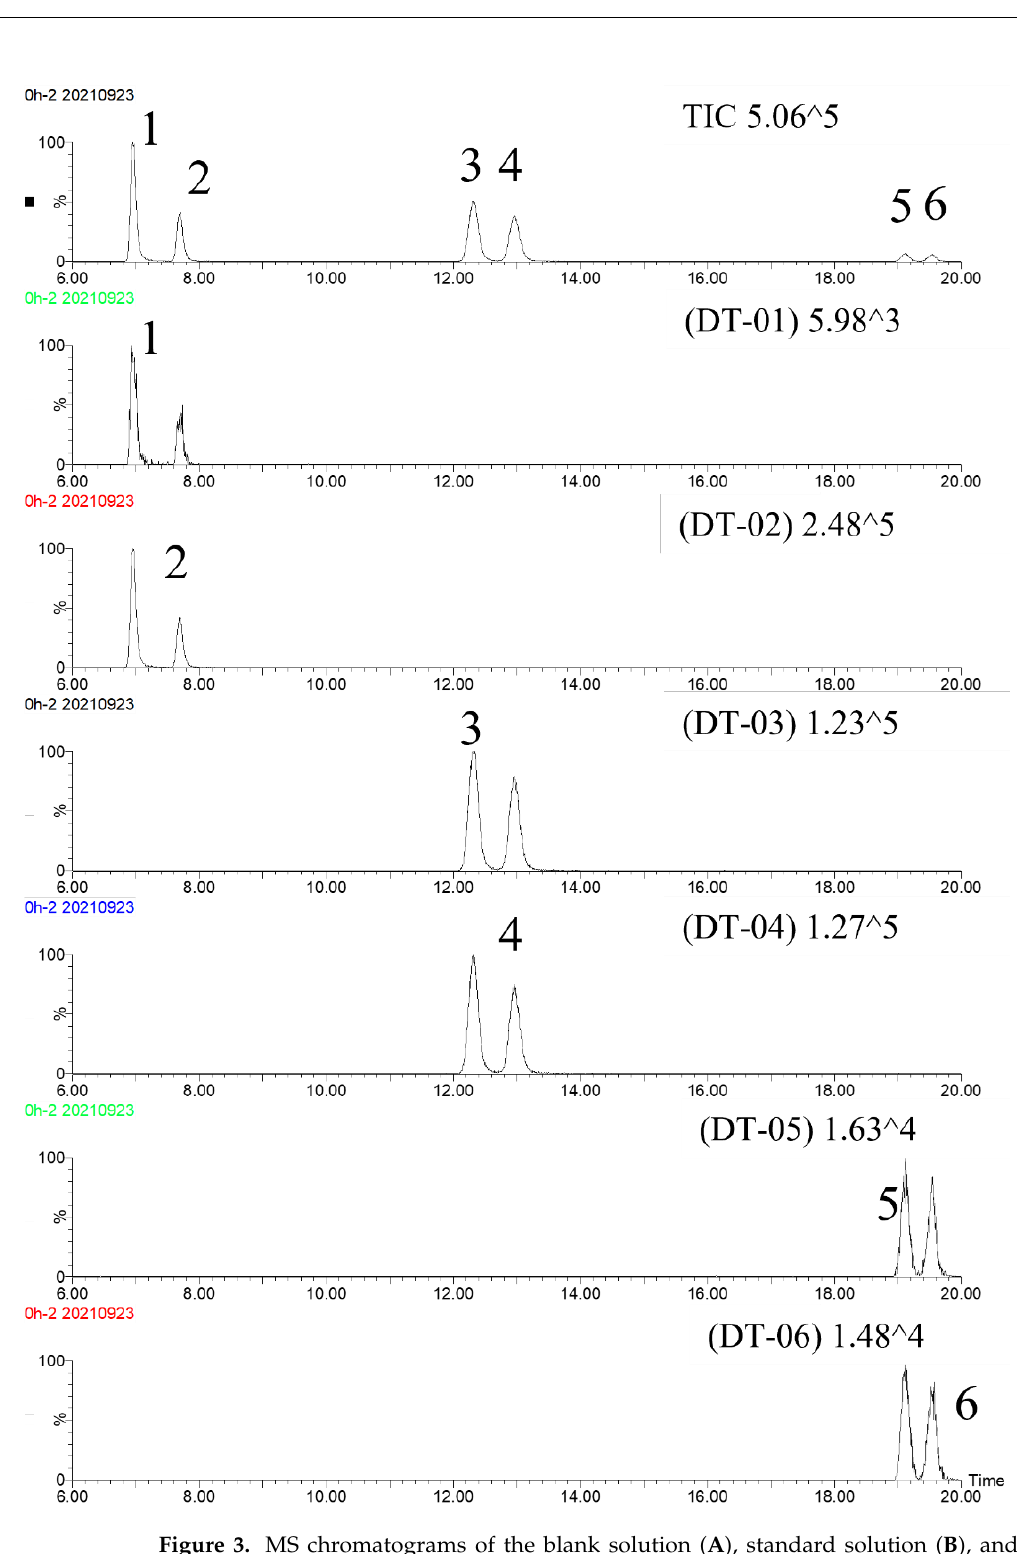
Figure 3. MS chromatograms of the blank solution ( A ), standard solution ( B ), and sample ( C ). Trans -emodin-emodin dianthrones (1), cis -emodin-emodin dianthrones (2), trans -emodin-physcion dianthrones (3), cis -emodin-physcion dianthrones (4), trans -physcion-physcion dianthrones (5) and cis -physcion-physcion (6).